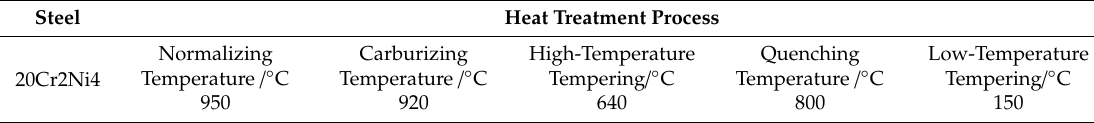
Table 3. Temperature of the heat treatment process for gear steel.